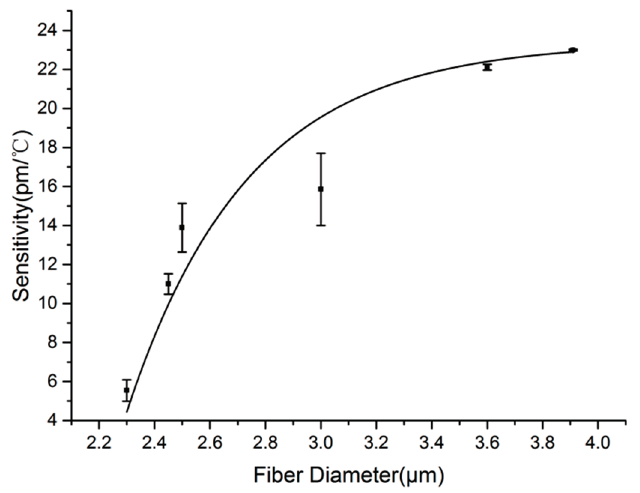
Figure 8. The dependence of sensitivity on fiber diameter. The error bars show the differences between experimental and fitting